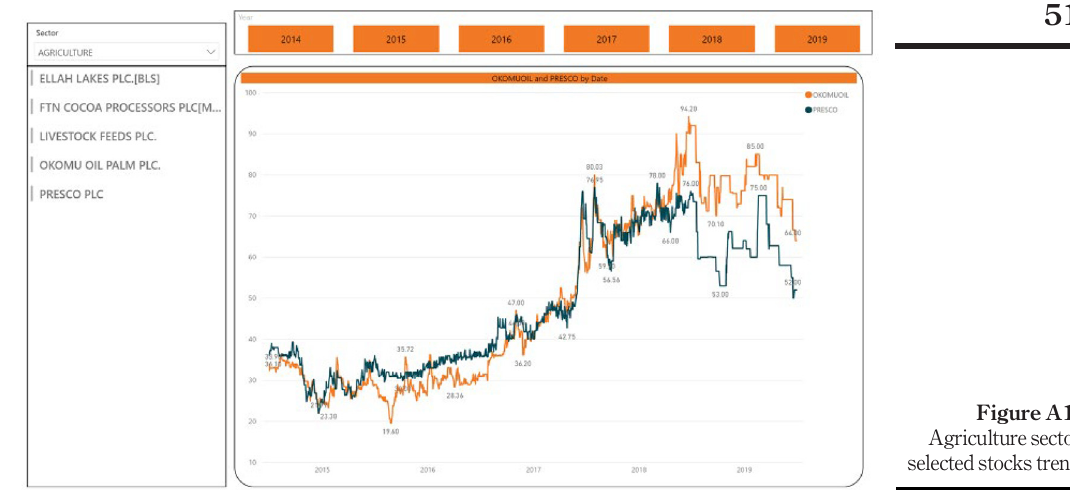
Figure A1. Agriculture